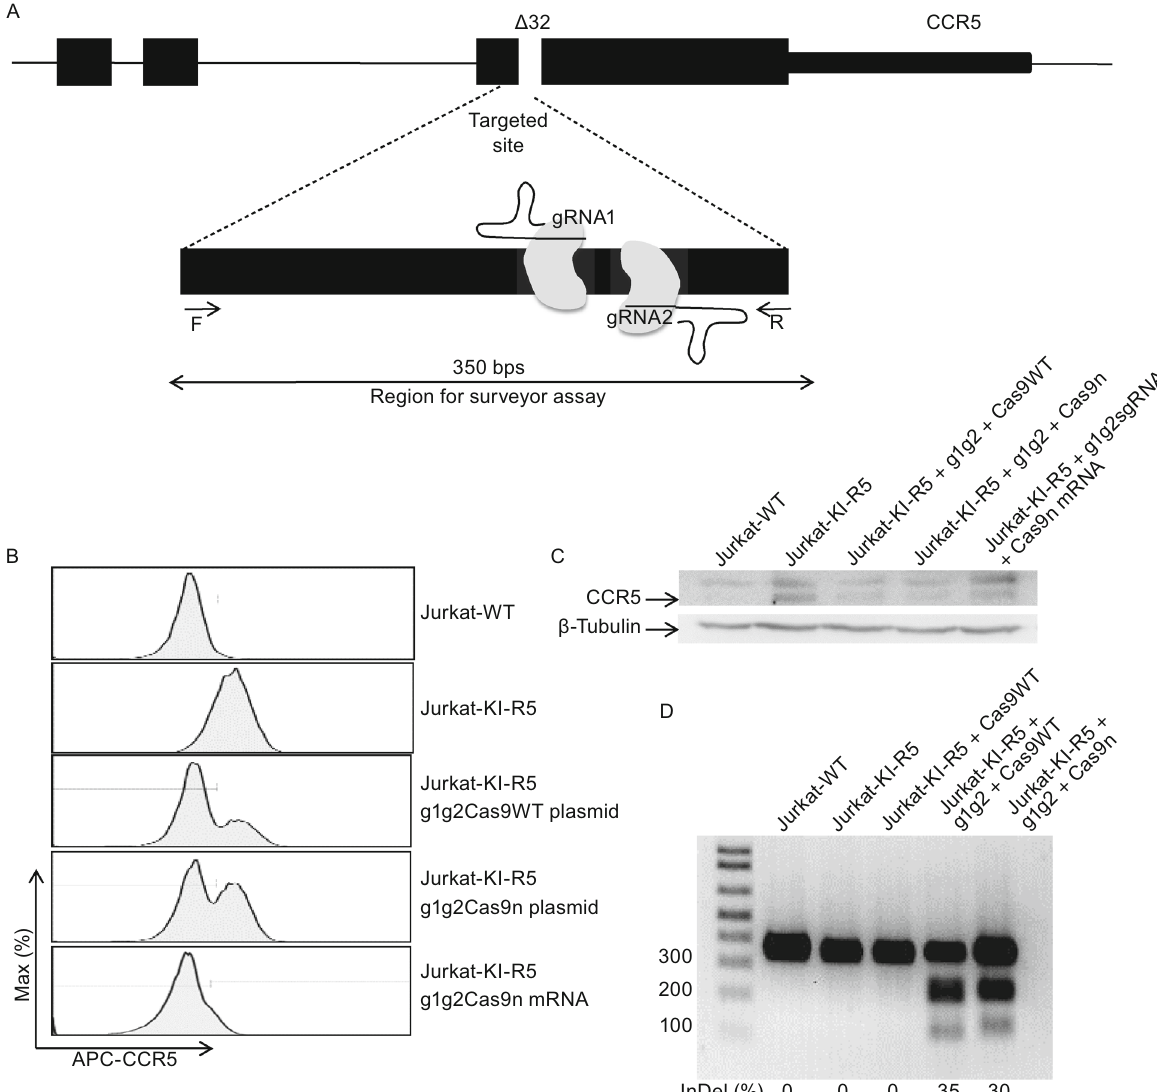
Figure 2. Ef fi cient disruption of CCR5 in Jurkat-KI-R5 cells using plasmid or RNA-based CRISPR/CAS9 technology . (A) Schematic diagram of the dual gRNAs targeting the endogenous CCR5 gene. Forward and reverse primers were used to